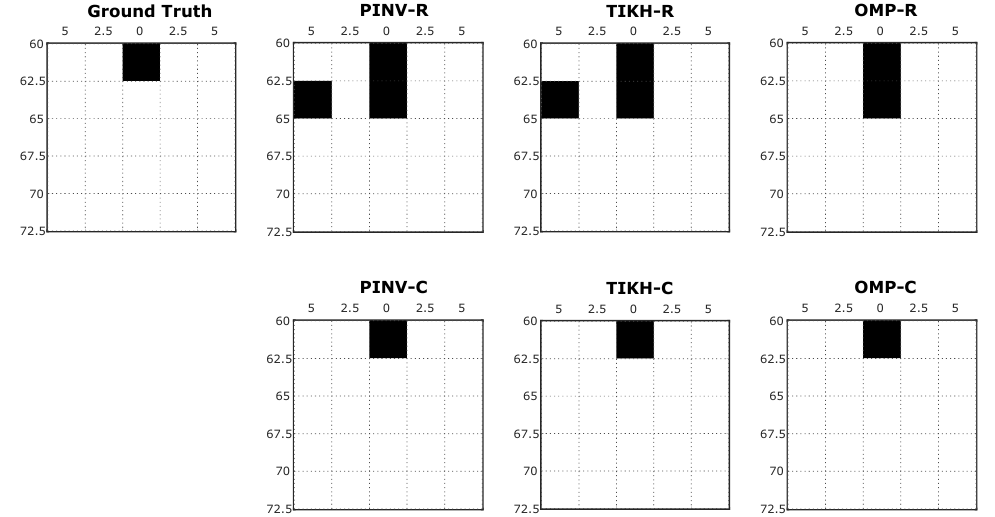
Figure 10. Examples of reconstructed images with a single obstacle in the environment after thresholding. The reconstructed images after thresholding, for the experiments with two obstacles in the environment, are shown in Figure 11. The algorithms using the complex-valued model presented the best results, which precisely correspond to the ground-truth, while the ones that used the real-valued model still presented reconstruction errors.